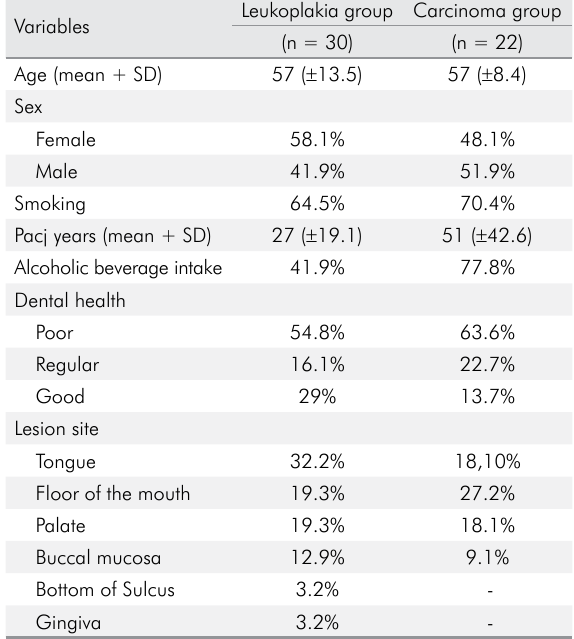
Table 1. Demographic and behavioral data about the patient